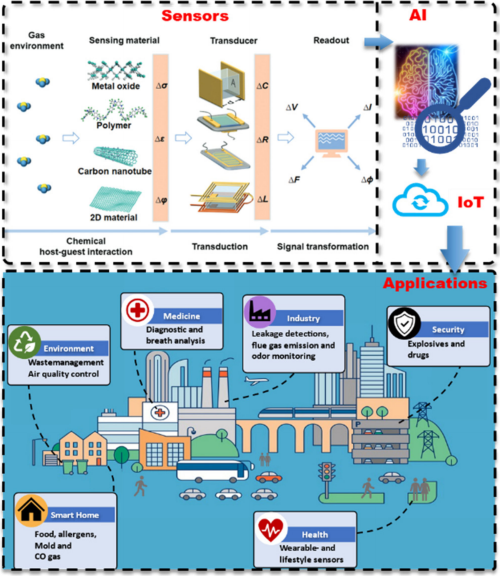
Figure 5. Schematic overview of smart sensor systems from the transduction of sensor signals, via the artificial intelligence and IoT connection for applications in various sectors. Adapted from